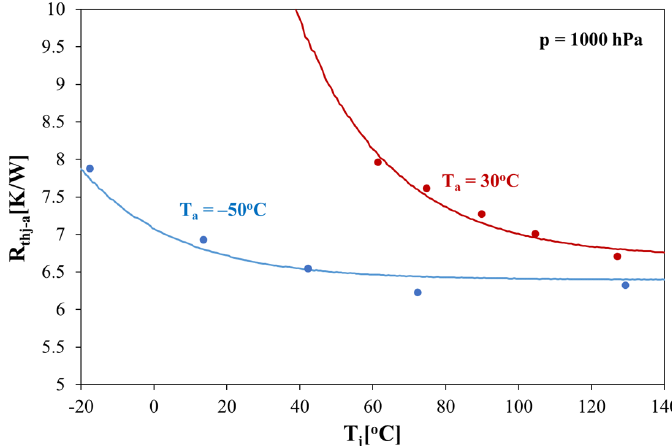
Figure 5. Measured and computed dependences of thermal resistance of the tested diode on the junction temperature for two values of atmospheric pressure.